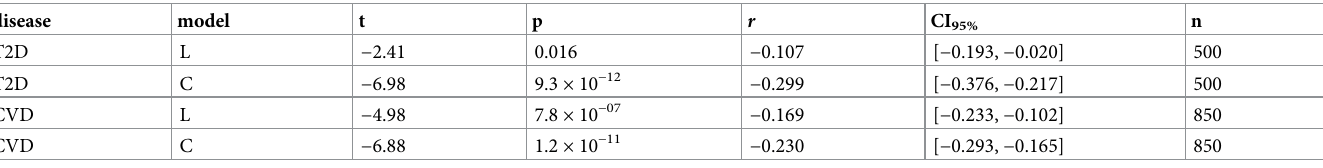
CVD, cardiovascular disease; T2D, type 2